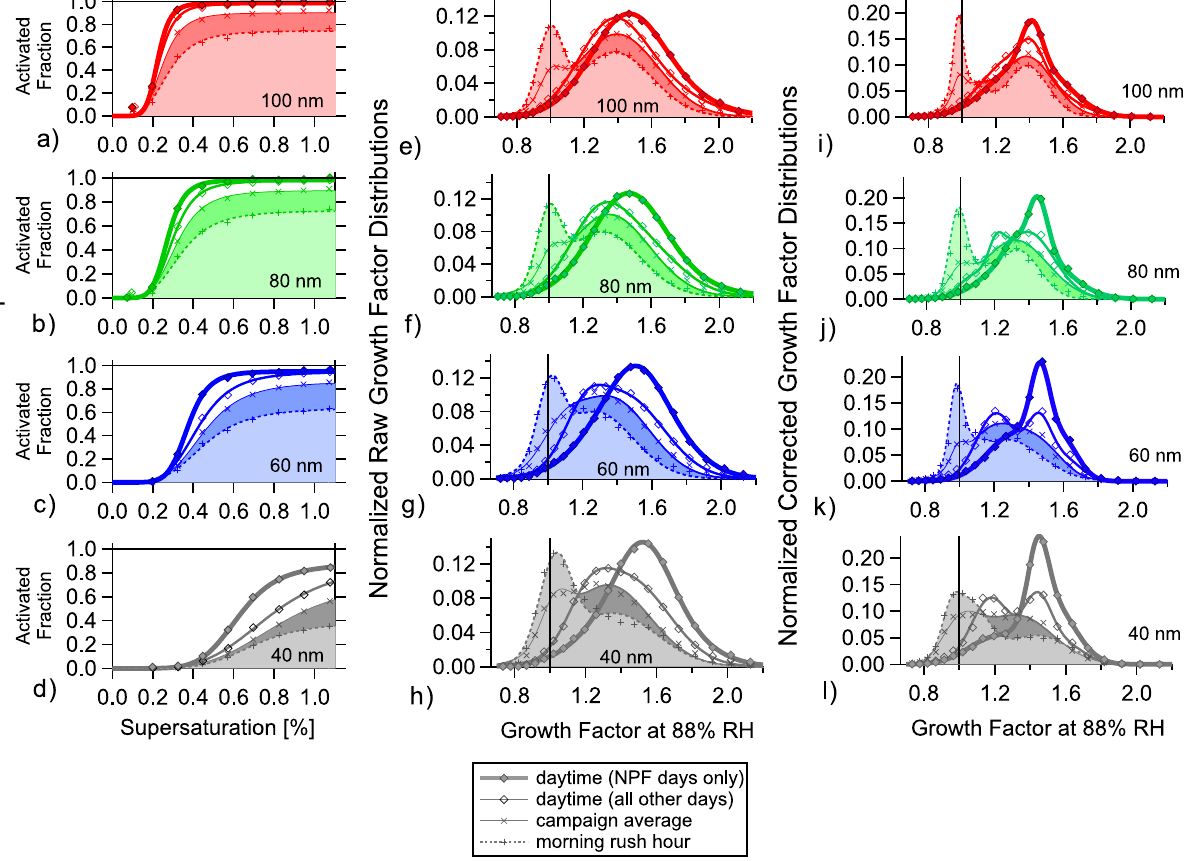
Fig. 7. CCN activation curves (a–d) , raw growth factor distributions (e–h) and inverted growth factor distributions (i–l) averaged over different time periods and colored by particle Fig. 7. CCN Activation curves (a–d), raw growth factor distributions (e–h) and inverted growth factor distribu- tions (i–l) averaged over different time periods and colored by particle size.